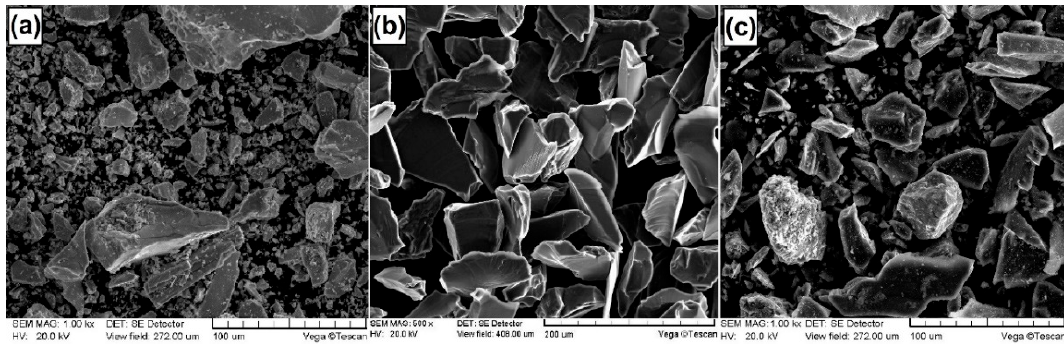
Figure 1. Size and morphologies of powders particles: ( a ) Fe–B; ( b ) B 4 C; ( c ) Si.